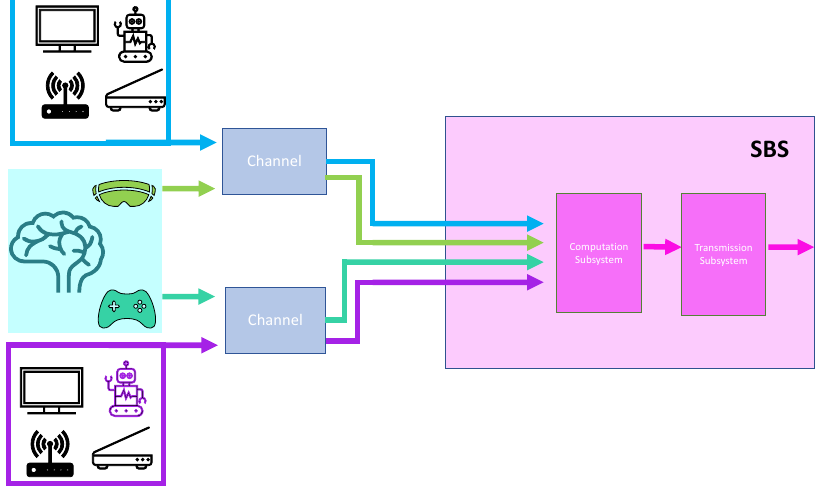
Figure 1. System